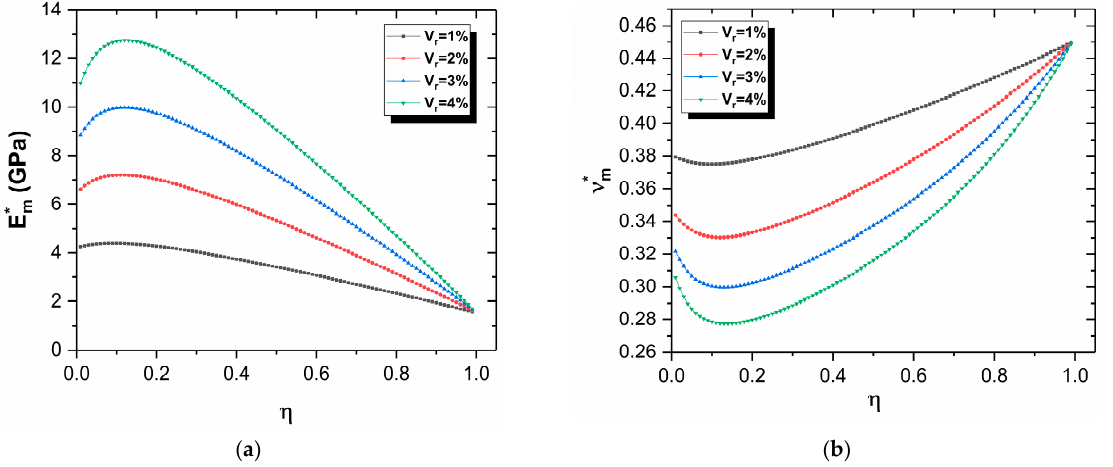
Figure 14. Effective elastic moduli of composite reinforced by random CNT inclusion in PP matrix, in function of η for µ = 0.2 with a maximum of Young’s modulus E ∗ m and minimum of Poisson’s ratio ν ∗ m : ( a ) effective Young’s modulus E ∗ m ; and ( b ) effective Poisson’s ratio ν ∗ m